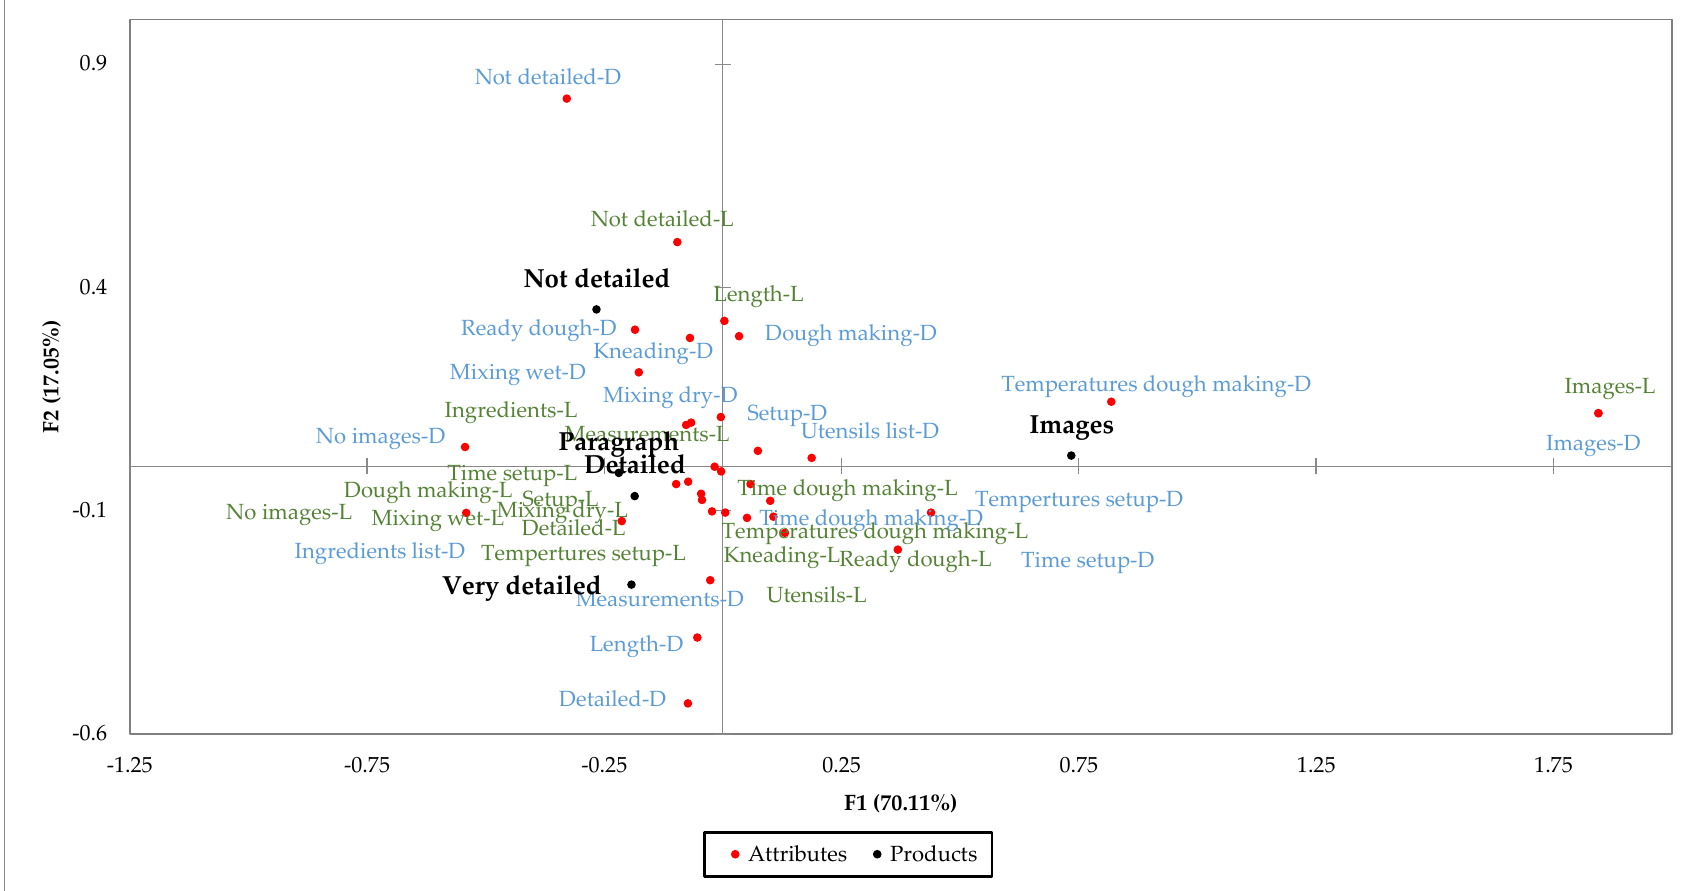
Figure 6. Correspondence analysis factor map representing five wheat recipes and 18 liking (L) and disliking (D) factors. This factor map represents 87.17% of the total variance, with factor 1 contributing to 70.11% and factor 2 covering 17.05% of the variance.